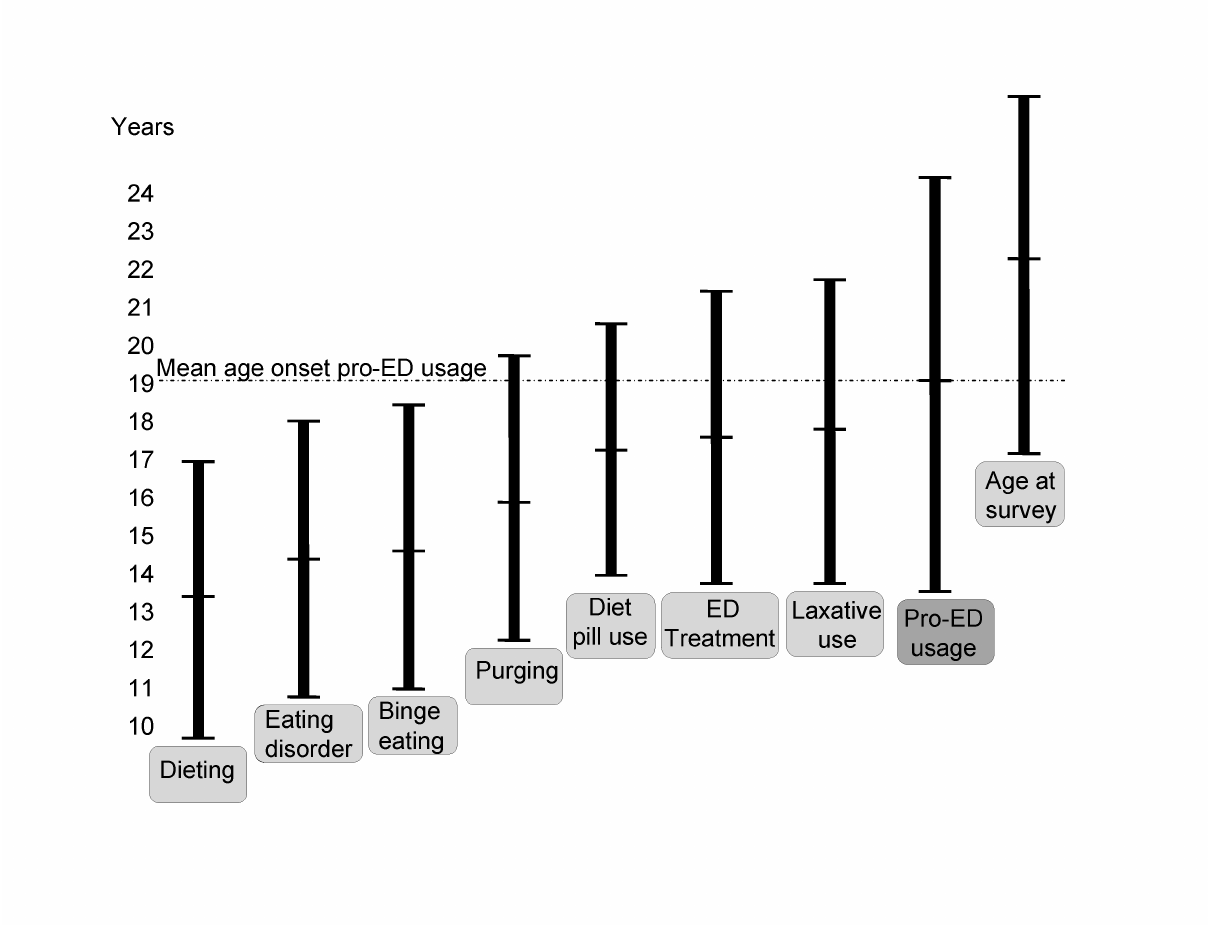
Figure 3. Self-reported age of onset of dieting behaviors and pro-eating disorder (ED) website usage. Mean age of onset of ED-related